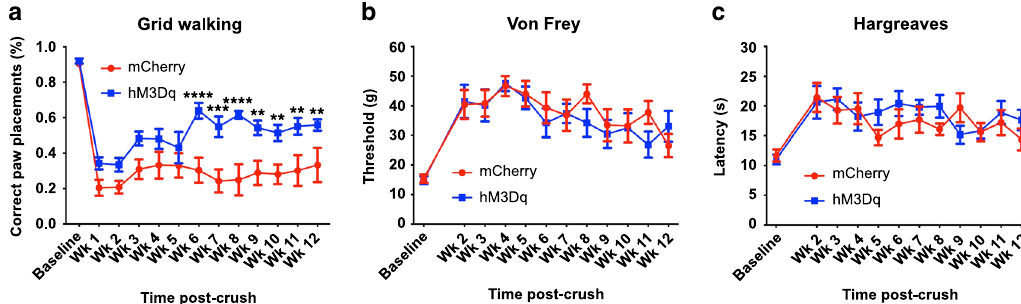
Fig. 5 Repeated activation of adult hM3Dq + DRG neurons improves proprioceptive functional recovery. Sensory testing was performed before dorsal root crush (baseline testing) and every week after dorsal root crush from week 2 to week 12. a In the grid walking test, both animal groups had comparable de fi cits in their ability to correctly place their affected forepaw on rungs while walking on a gridded platform on the grid early on. While the de fi cit persisted in the mCherry + animals, repeated, daily activation of hM3Dq + DRGs with CNO resulted in improved paw placement starting 6 weeks post injury. b Dorsal root crush compromised mechanical sensation in the ipsilateral forepaw, as determined using Von Frey fi laments. The response threshold did not differ between groups at any testing time point. c Thermal sensitivity was also diminished after dorsal root crush injuries, as indicated in the Hargreaves ’ test. Both animal groups showed increased response latency after the injury. There were no differences between groups. N = 7 animals per group. Mean ± SEM. Two-way ANOVA and post-hoc multiple comparisons testing using the two-stage step-up method of Benjamini, Krieger, and Yekutieli, ** p < 0.01 (mCherry vs. hM3Dq Week 9 p = 0.0023, Week 10 p = 0.0049, Week 11 p = 0.0027, Week 12 p = 0.0065), *** p = 0.0003, **** p < 0.0001. Source data are provided as a Source Data fi